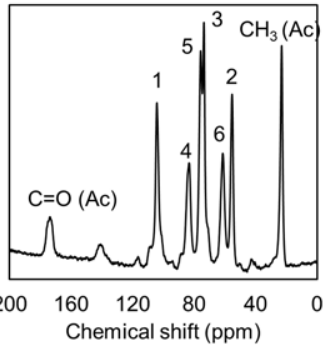
Figure 2. 13 C NMR spectrum of cricket chitin.